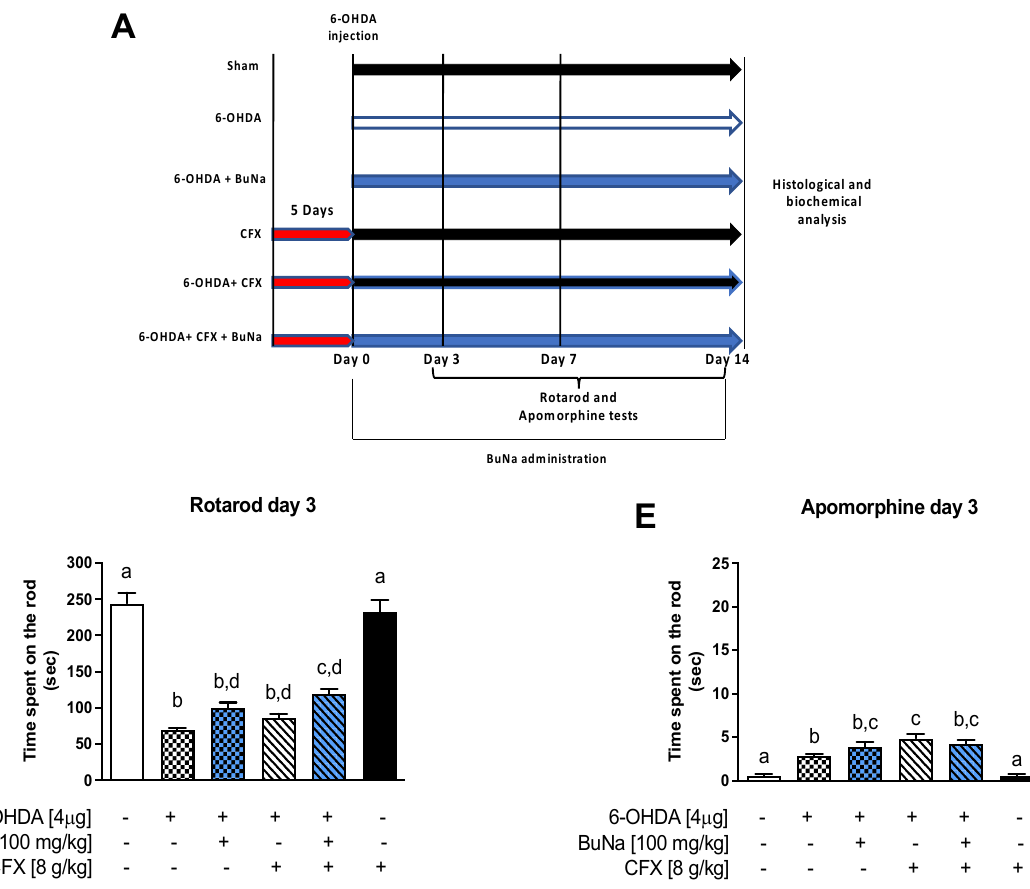
Figure 1. Grouping and schedule ( A ). Effects of BuNa (100 mg/kg) on motor coordination in 6- OHDA-lesioned mice pretreated or not with CFX ( B - D ). CD1 mice were treated with BuNa daily, and time spent on the rod (sec) was assessed and recorded at 3 (A), 7 (C), and 14 (D) days. Values are expressed as mean ± SEM of retention time on the rotating bar. Evaluation of apomorphine- induced rotational behavior ( E - G ). The number of net ipsilateral and contralateral rotations was counted per minute in all animals from all groups after 3 (E), 7 (F), and 14 (G) days. Values are expressed as mean ± SEM ( n = 8-12) of all turns collected during 40 min. Labeled means without a common letter differ, p < 0.05.